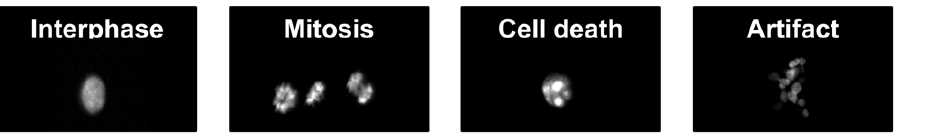
Figure 3. Sample images of the four phenotype classes. Interphase cells are round or elliptical with smooth boundaries. The class of mitosis includes cells in the sub-phases of the mitotic process, i.e. pro-metaphase, metaphase, and anaphase. The class cell death represents dying cells observed by disintegrated nuclei. The class artifact represents cell aggregations that could not be further segmented and over-segmented cells.